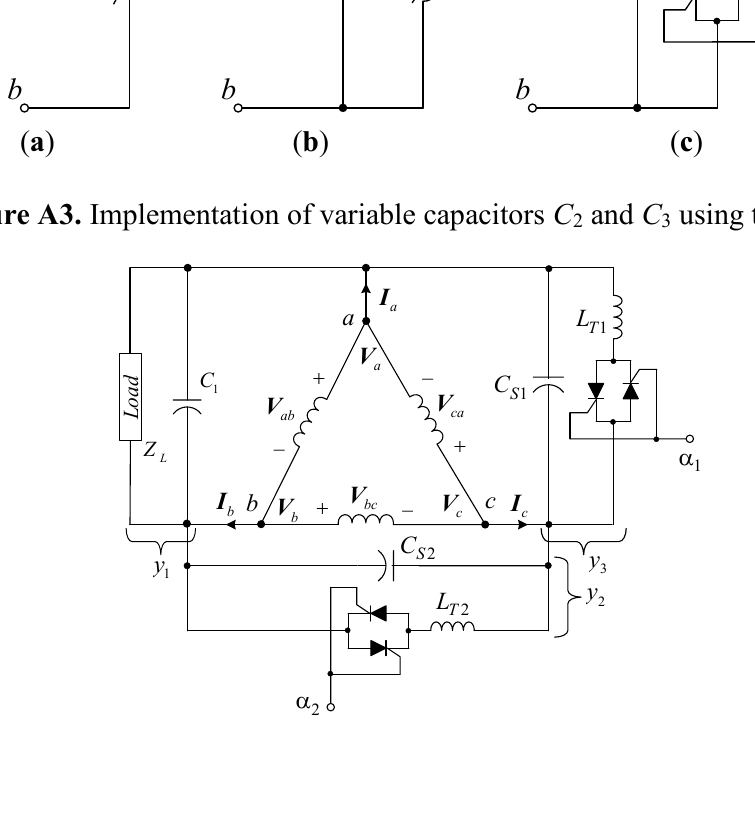
Figure A2. Basic principle of realizing a variable capacitor using an SVC. ( a ) A variable capacitor C ; ( b ) A fixed capacitor C composed of a TCR with a shunt capacitor C